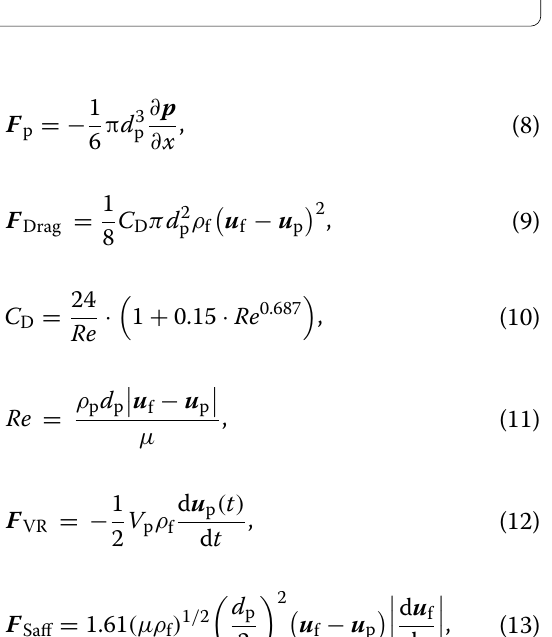
Figure 3 CFD-DEM coupling simulation schematic